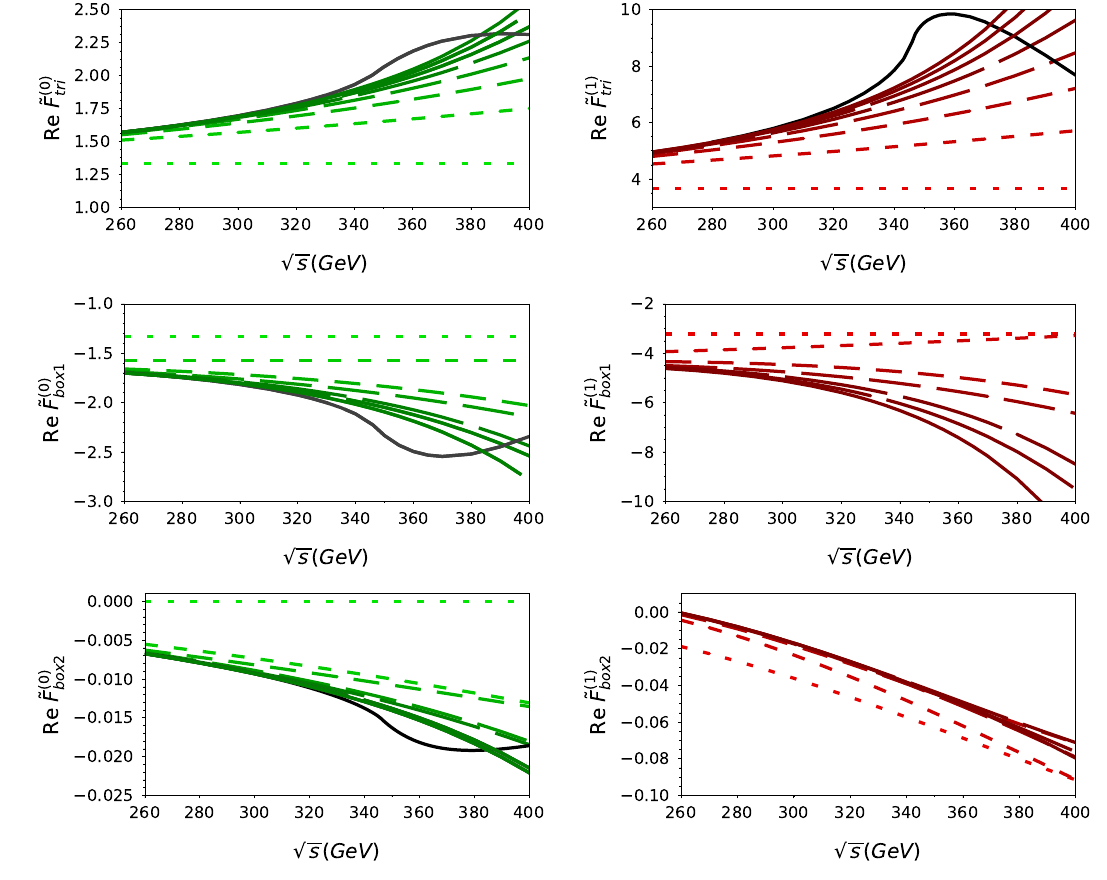
p s for r p = 0 : 01. T for the triangle and t